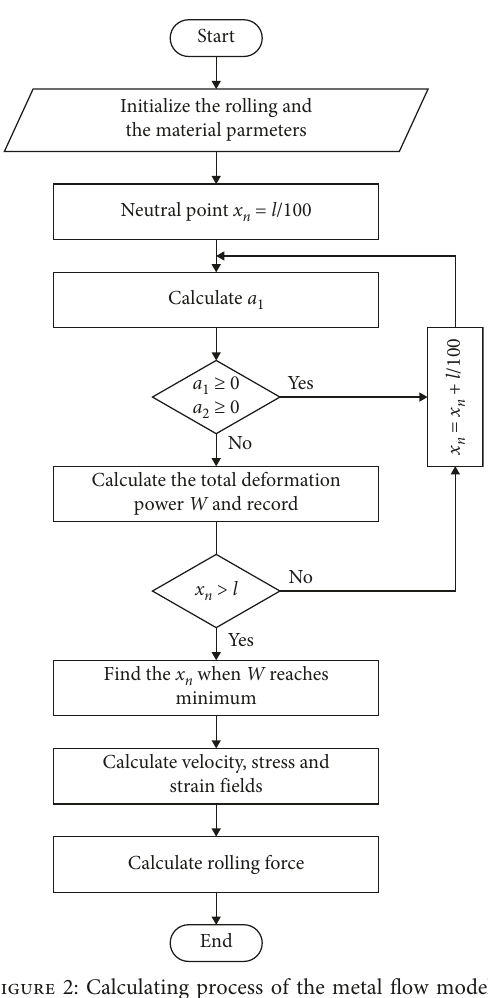
Figure 2: Calculating process of the metal flow